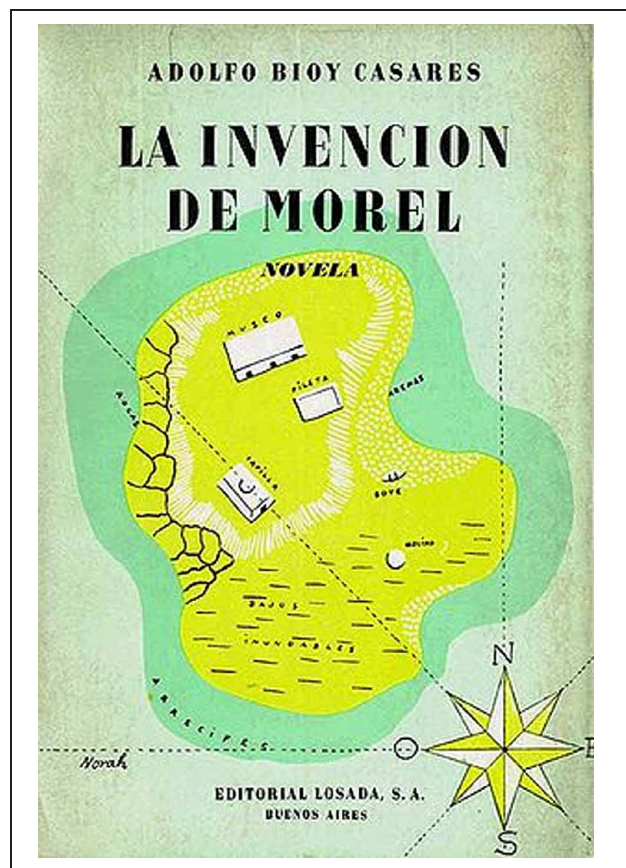
FIGURE 1 | The first Spanish edition of “The Invention of Morel”, depicting the map of the island where the scientist Morel would have created and used his innovating machine. Copyright: Editorial Losada S. A., Buenos Aires, 1940, Cover by: Norah